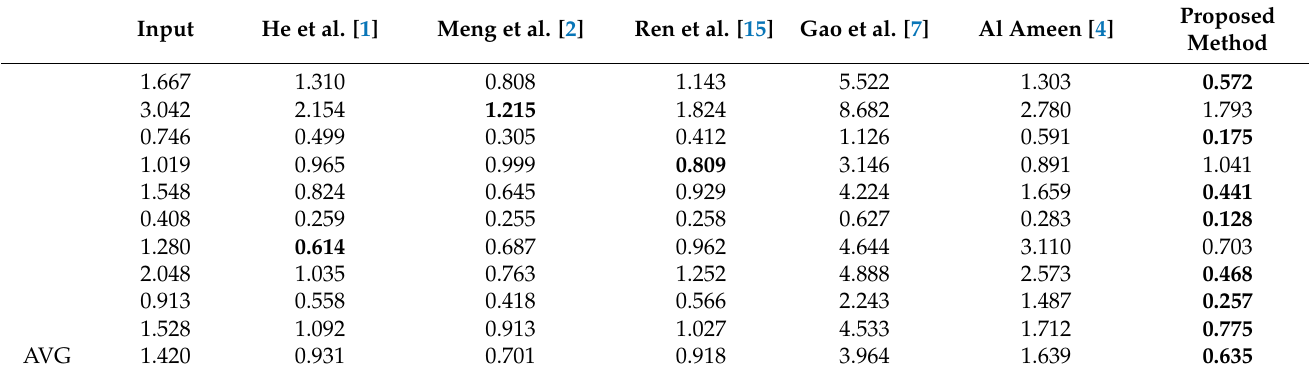
Table 4. The comparison of the FADE [36] scores from Figure 6 (If the score is low, the image is well enhanced. The lowest are indicated in bold ).